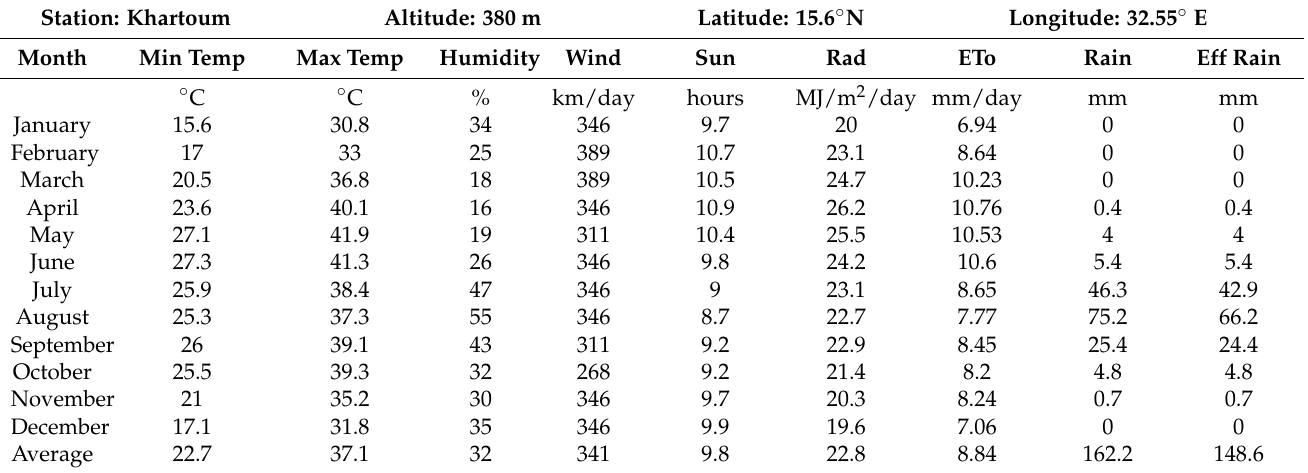
Table 2. CROPWAT 8 model climatic rainfall data and ETo values of Khartoum Station (site 5), Sudan.